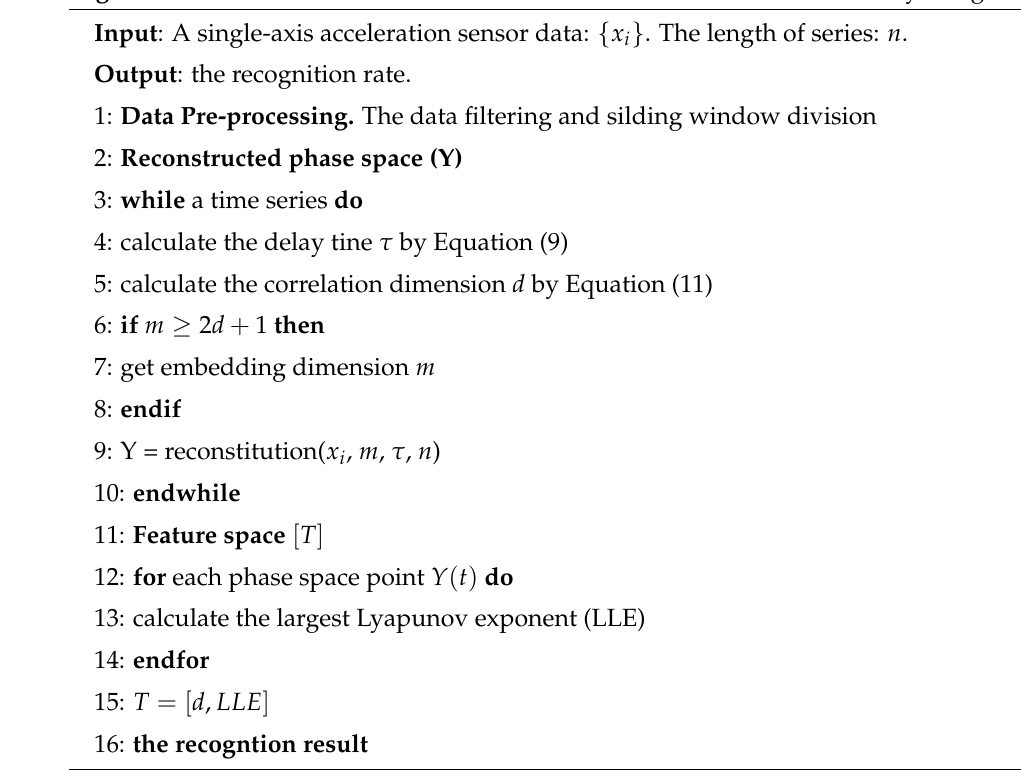
Algorithm 1 Pseudo-code of non-linear chaotic features-based human activity